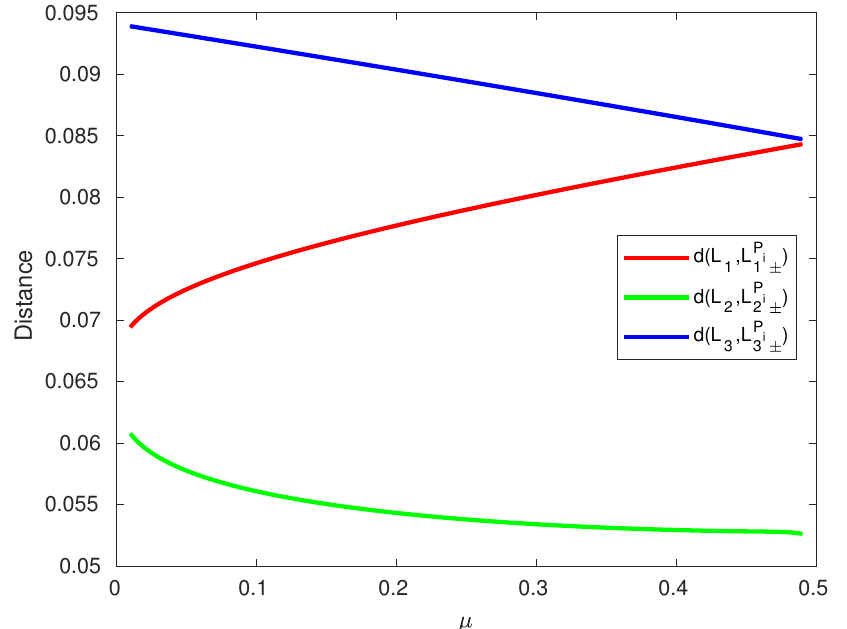
Figure 3. Distance versus mass ratio µ plot in the presence of the planetesimal belt effect for collinear equilibrium